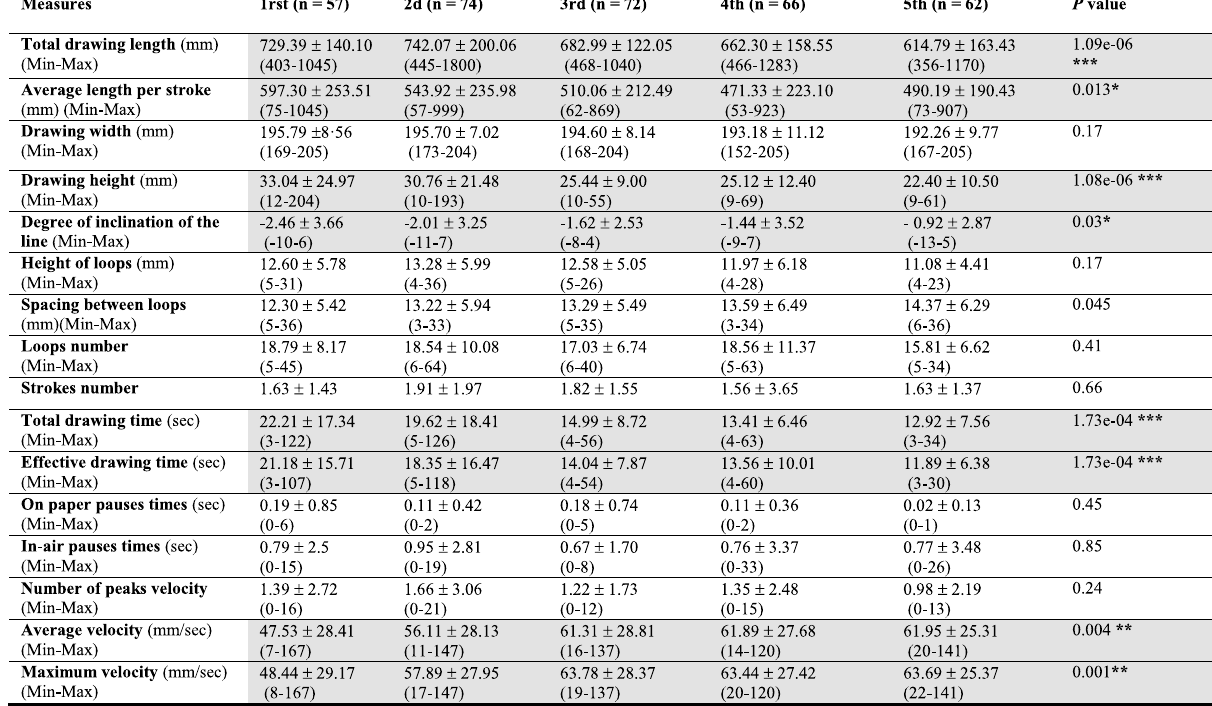
Table 3. Mean (± standard deviation) of spatial–temporal and kinematic measures by grade level in the whole sample (1 and 2, N = 331) for the copy of a line of cycloid loops. 1st 1st grade, 2nd 2nd grade, 3rd 3rd grade,